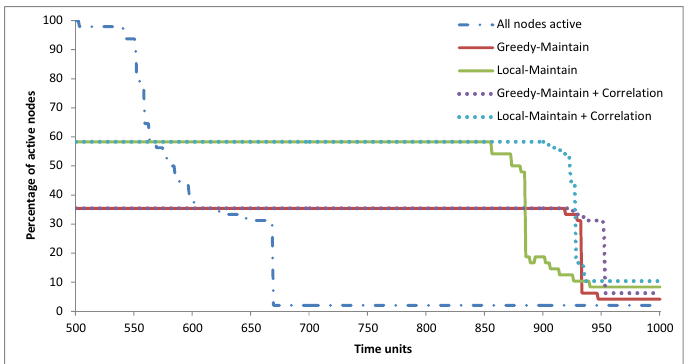
Figure 13. CIT-1’s percentage of active nodes over